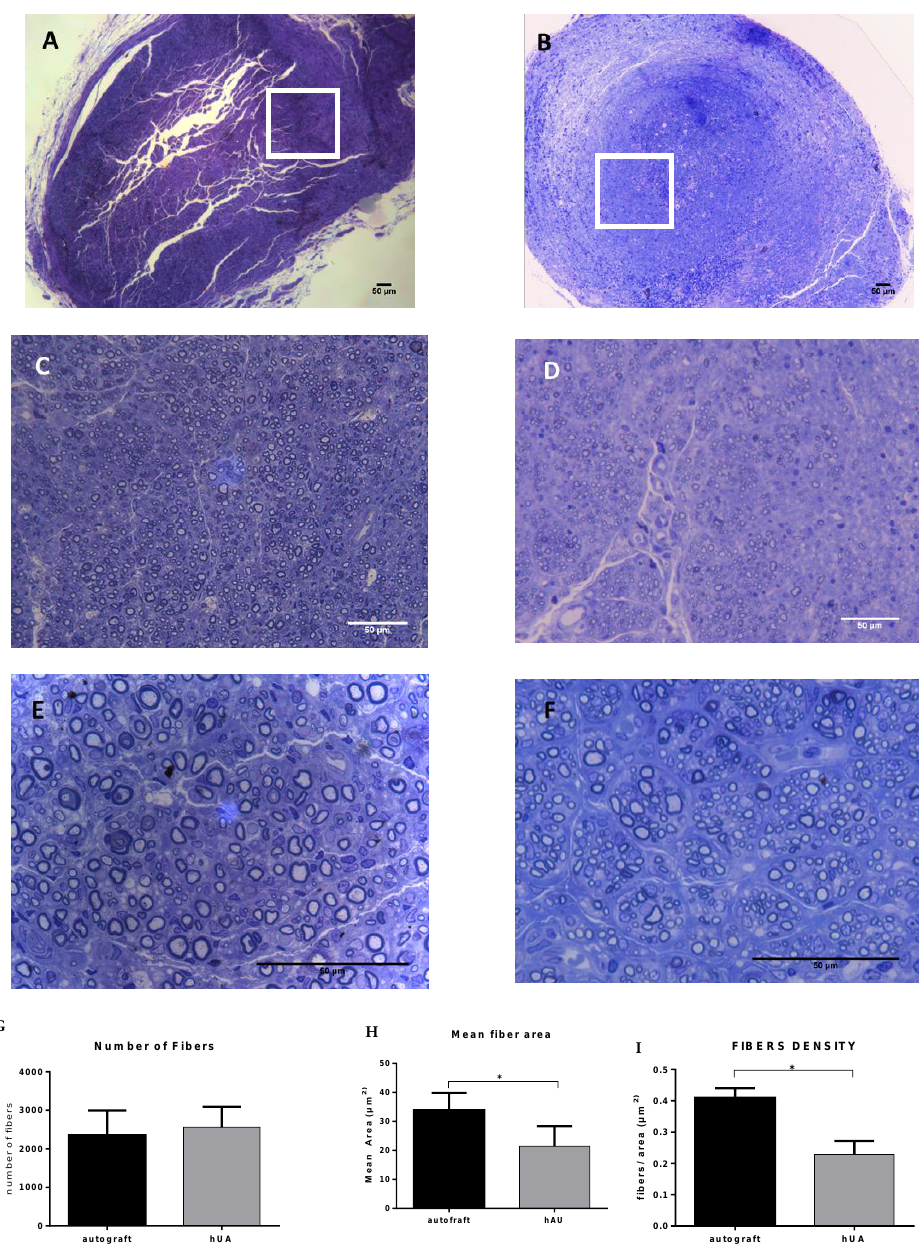
Figure 6. Morphometric analysis of regenerated sciatic nerve ( A , C , F ) toluidine blue stained, middle portion of the autograft after 12 weeks at different magnifications. 10, 40 and 100 × respectively; ( B , D , E ) toluidine blue stained, middle portion of the hUA graft after 12 weeks at different magnifications. 10, 40 and 100 × , respectively. The white boxes in ( A , B ) highlighted the area that was magnified and presented in the following images ( C , D , E , F ) scale bar 50 µ m; ( G ) number of fibers; ( H ) mean fiber area; ( I ) fiber density was evaluated and compared to statistical analysis * p < 0.05.